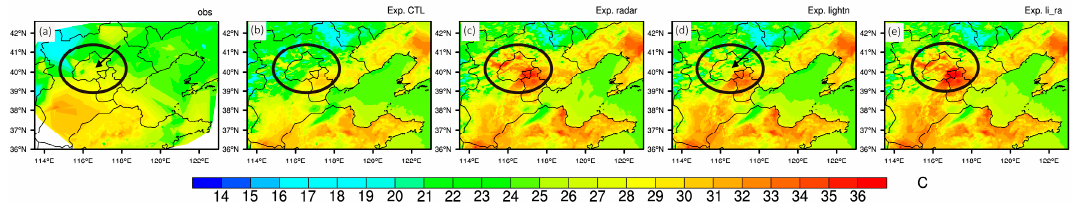
Figure 5. Observed surface temperature ( a ); and the surface temperature filed in Exp. CTL ( b ); Exp. radar ( c ); Exp. lightn ( d ); and Exp. li_ra ( e ) at 0300 UTC(unit: °C).